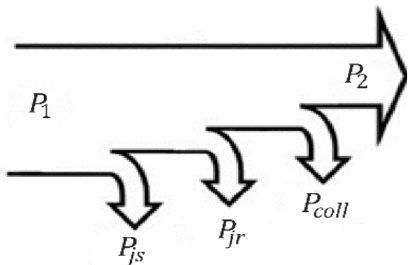
Figure 2. A simplified Sankey diagram: P 1 —input power, P 2 —output power, P coll —collective losses, P js —stator winding (Joule) loss, P jr —rotor winding (Joule)